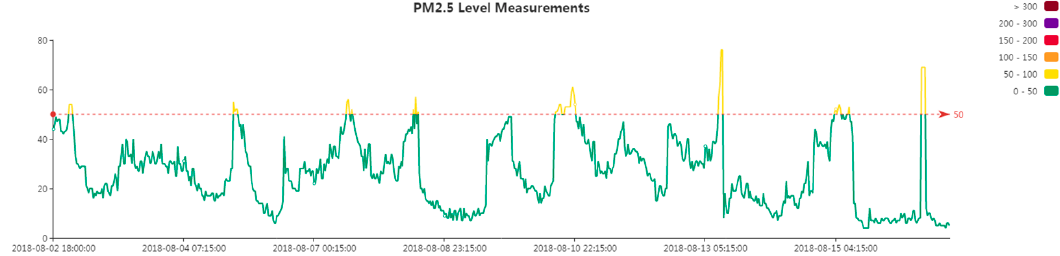
Figure 13. Indoor PM2.5 Concentration.